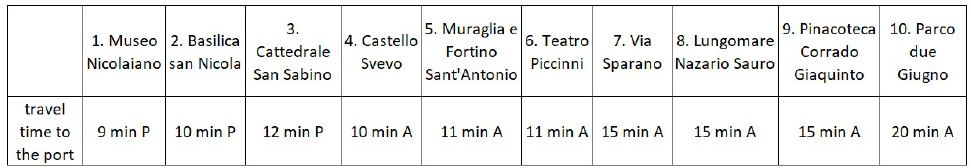
Figure 15. Travel times from each node of G i to the